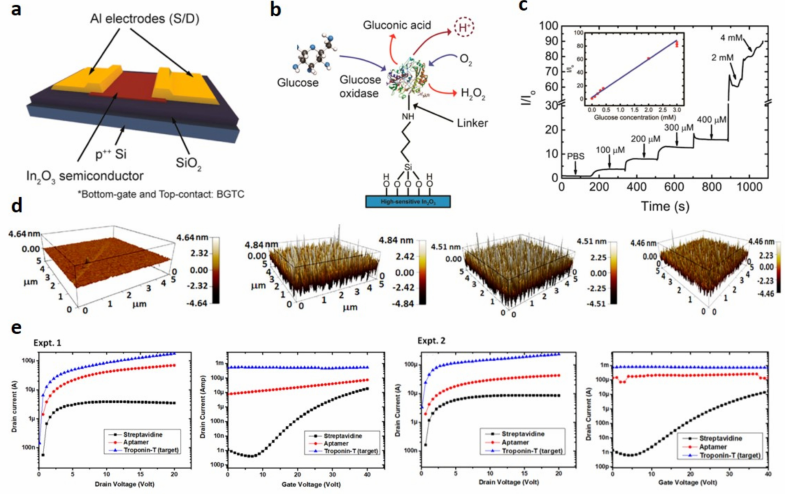
Figure 8. ( a ) Schematic diagram of the In 2 O 3 FET biosensor; ( b ) Enzymatic oxidation of